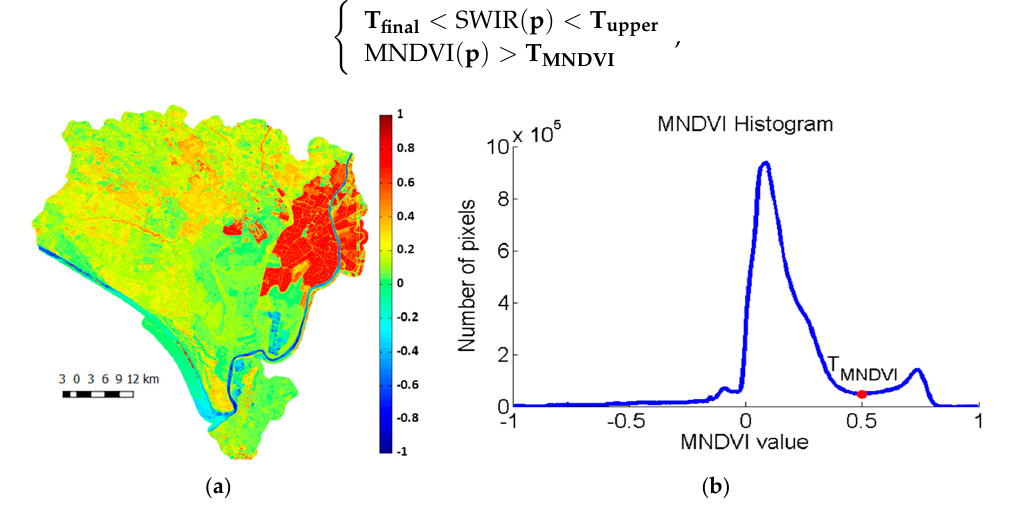
8. Figure 8. ( a ) MNDVI color map and ( b ) its histogram.